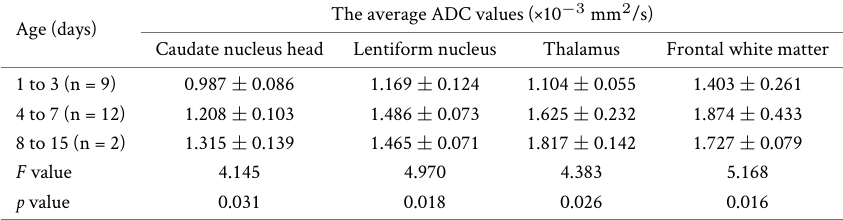
Table 5. The ADC values in different age groups of HIE